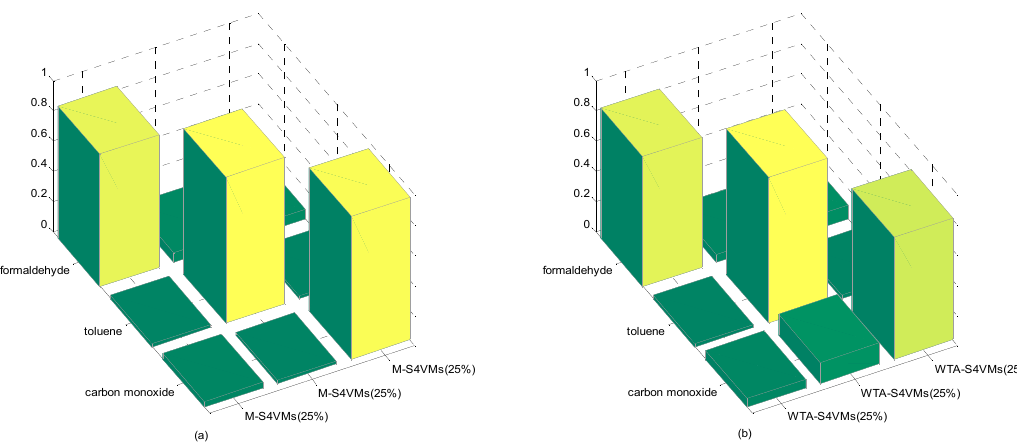
Figure 4. 50% unlabeled rate of the two methods. It illustrates the classification results based on three target gases by M-S4VMs ( a ) and WTA-S4VMs ( b ) when the unlabeled data account for 50%. It is obvious that M-S4VMs performs better than WTA-S4VMs especially in the classification of carbon monoxide.